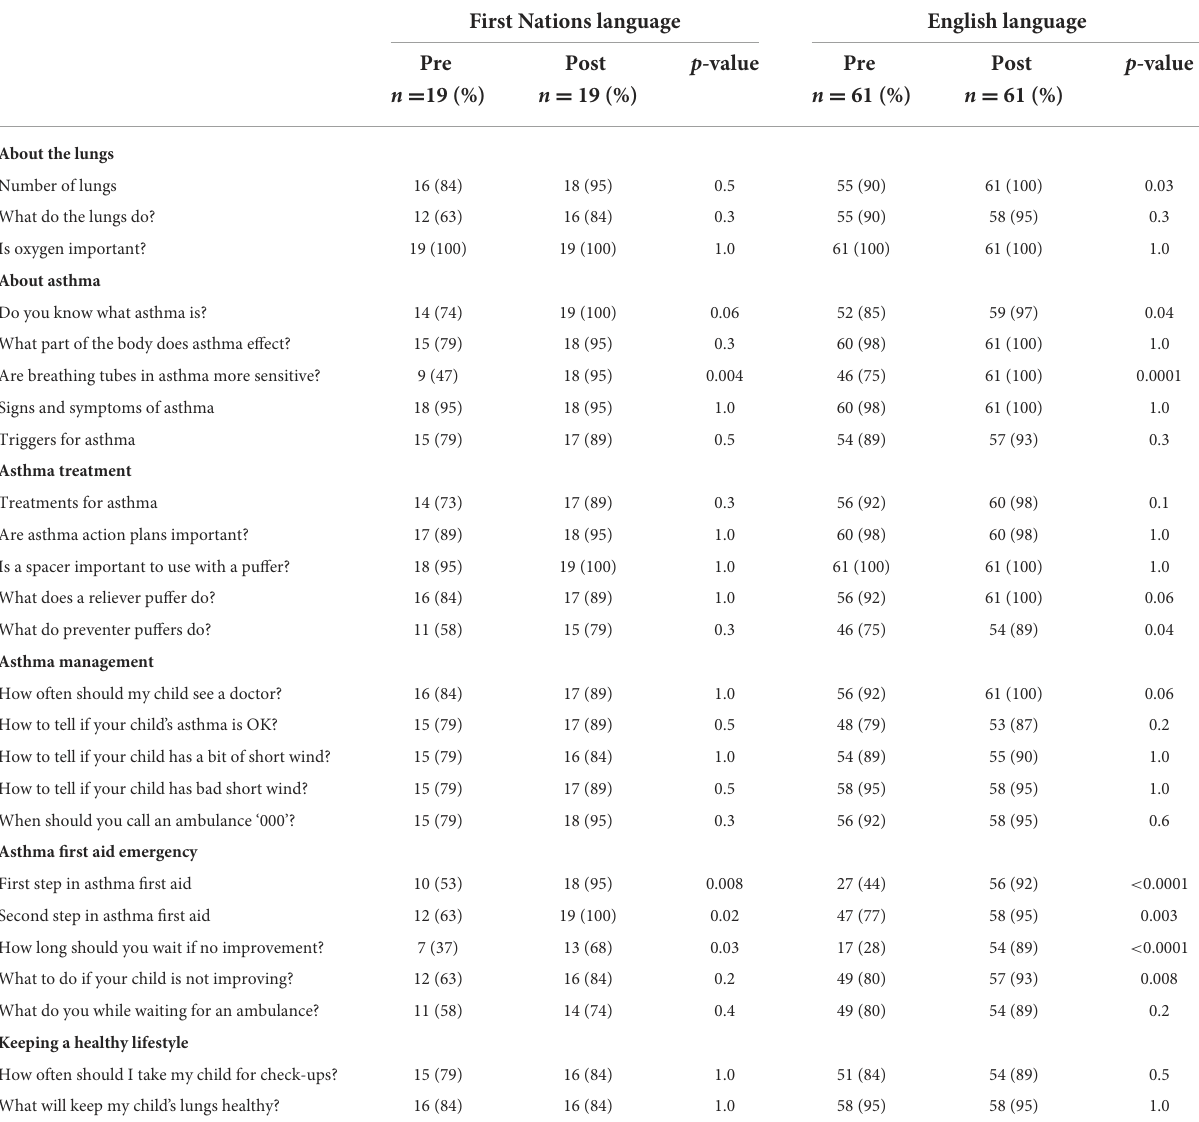
TABLE 3 Comparison of pre- and post-questionnaire scores from cares by language used. Questions by section Number (%) of carers who answered the question